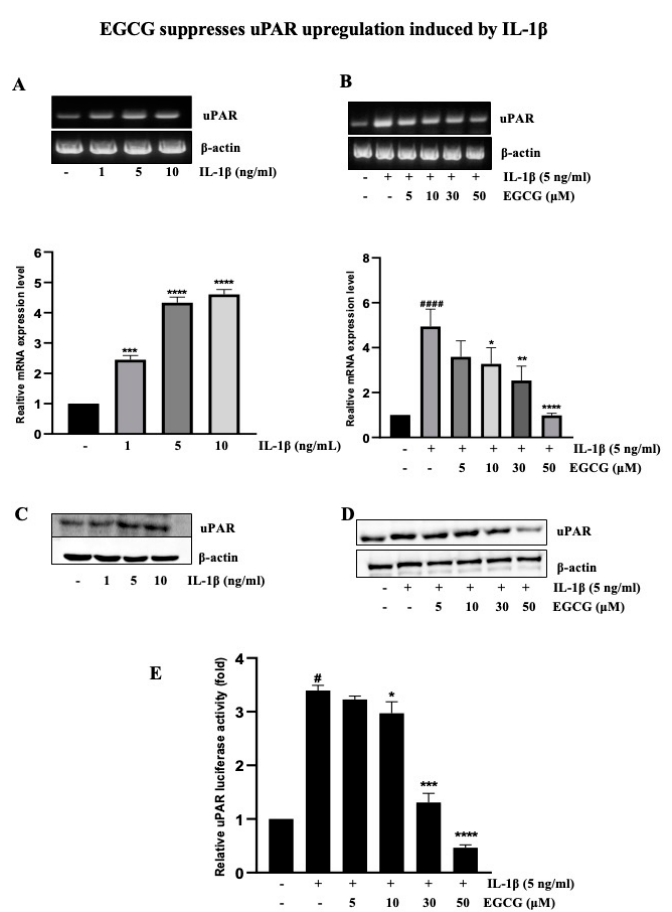
Figure 2. EGCG inhibits IL-1 β -induced uPAR expression in T24 bladder cancer cells. ( A ) T24 cells were treated with 0 − 10 ng/mL of IL-1 β for 4 h, and uPAR mRNA level was evaluated by RT-PCR. The bladder cancer cell line T24 was pretreated with different concentration of EGCG (5–50 µ M) for 1 h. The cells were then incubated with IL-1 β (5 ng/ ml) for 4 h. Then, mRNA was extracted and uPAR expression was evaluated by RT-PCR ( B ). ( C , D ) T24 cells were treated with 0–10 ng/mL IL-1 β for 4 h, and uPAR protein level was evaluated by Western blotting. The T24 cell line was pretreated with different concentration of EGCG (5–50 µ M) for 1 h. The cells were then incubated with IL-1 β (5 ng/ ml) for 4 h. Then, protein was extracted and uPAR expression was evaluated by Western blotting. ( E ) T24 cells transfected with the pGL3-uPAR plasmid were pretreated with 5–50 µ M for 1 h then incubated with 5 ng/ mL IL-1 β for 12 h submitted for the luciferase assay. The above data represent the mean ± SD from triplicate measurements ( # p < 0.05, #### p < 0.0001 versus control; * p < 0.05, ** p < 0.01, *** p < 0.001, **** p < 0.0001 versus IL-1 β